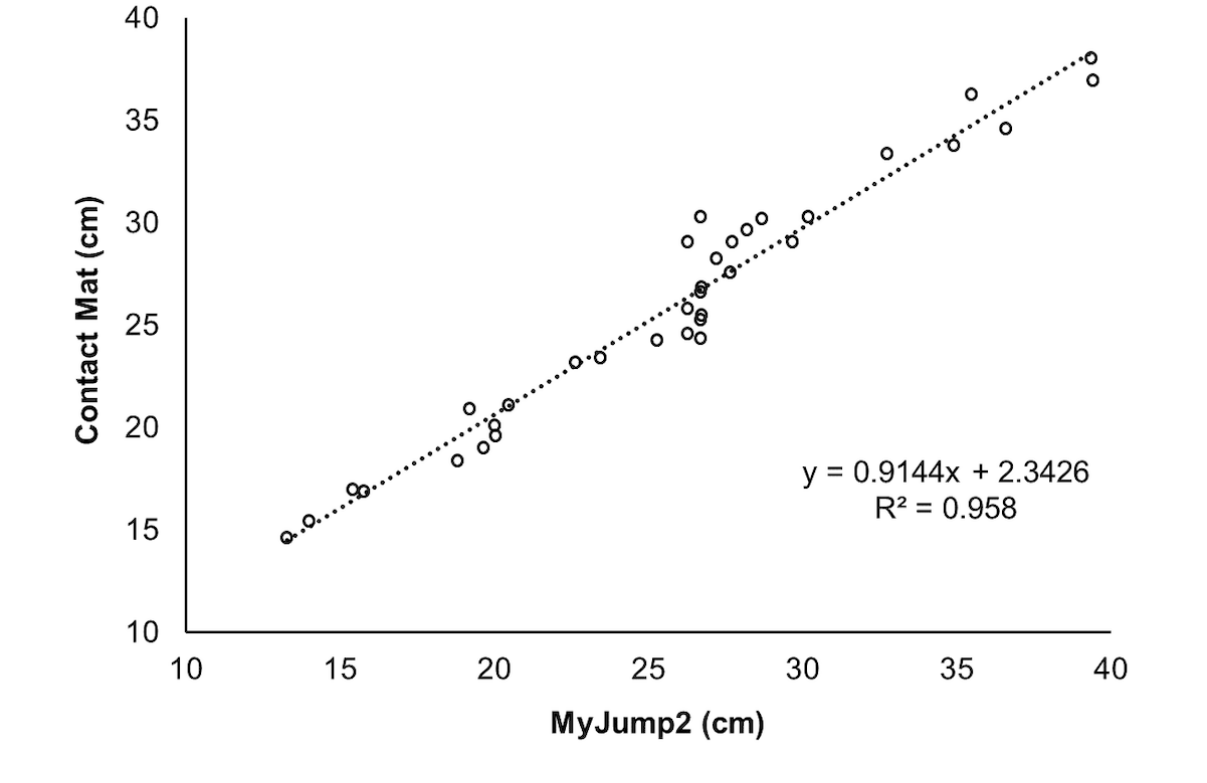
Figure 2. Correlation for agreement analysis of squat jumps.